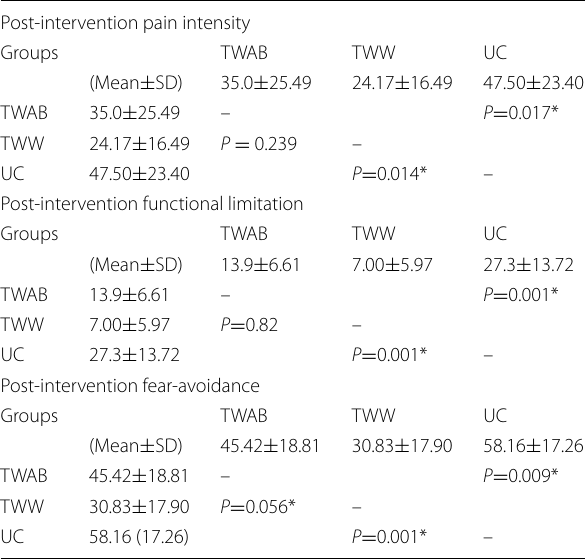
GRP A treadmill walk with abdominal bracing, GRP B treadmill walk without abdominal bracing, GRP C usual care, SD standard